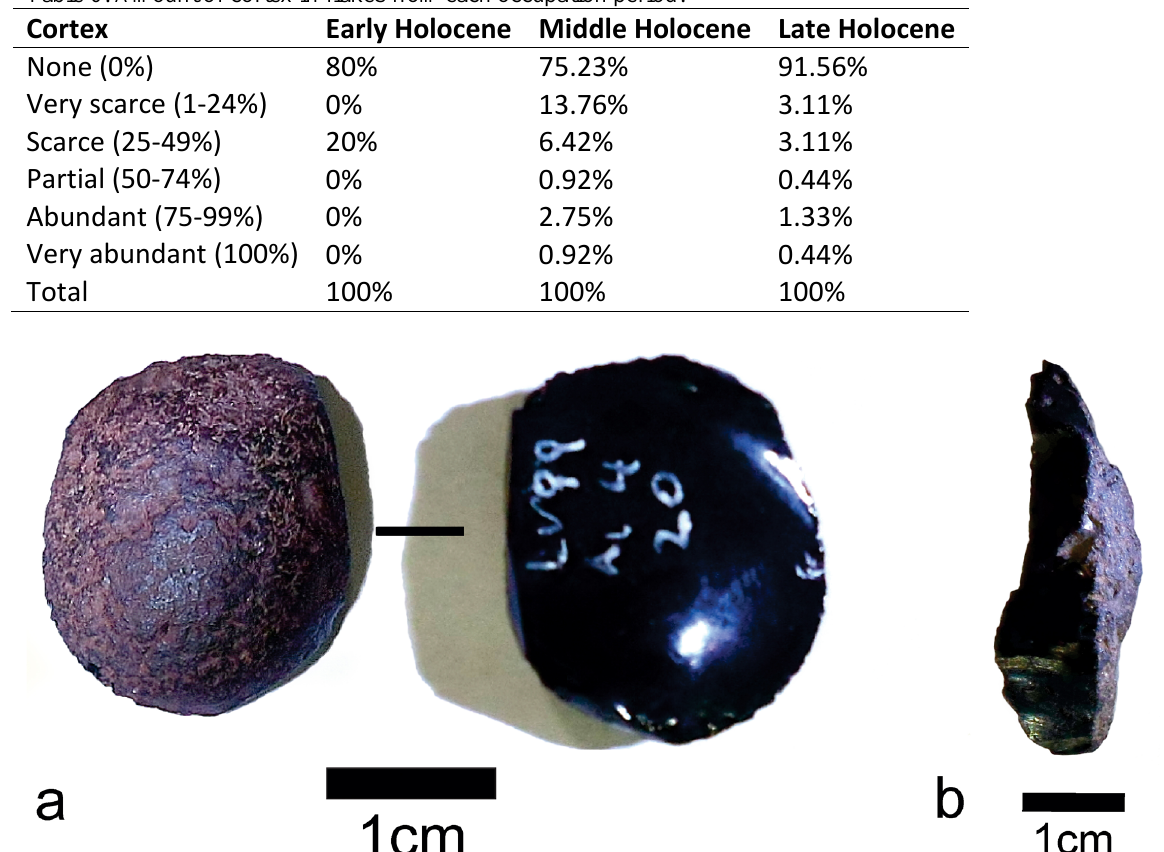
Figure 6. Mid Holocene flakes with residuary cortex. a. Decortication flake, LV. b. Core reduction flake, LM.